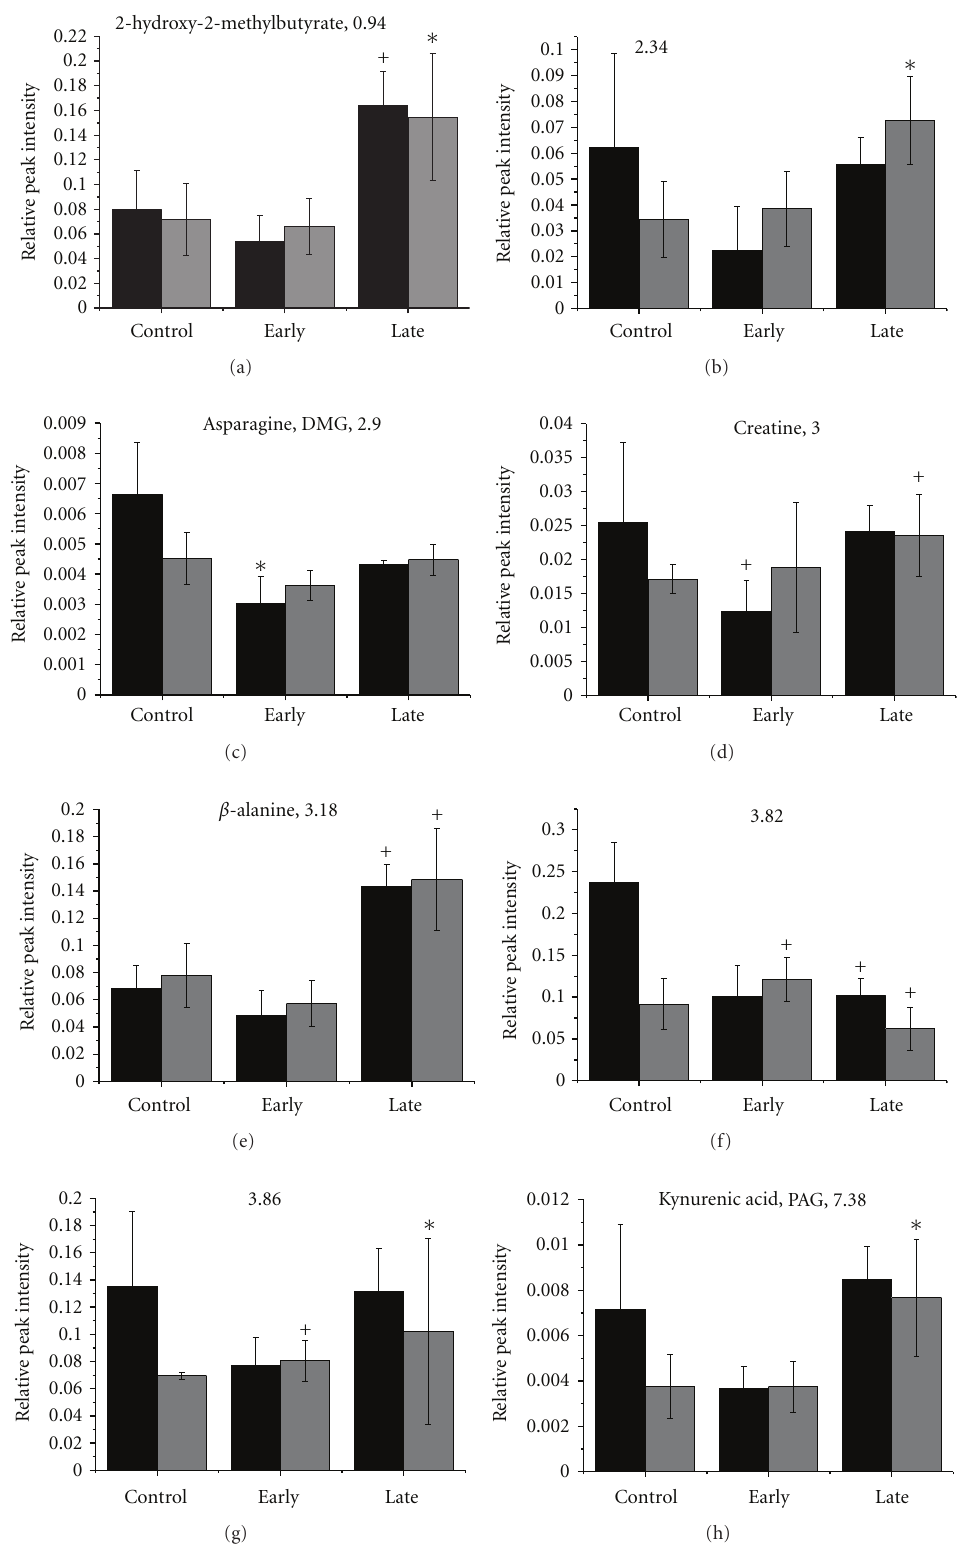
Figure 2: Perturbed metabolite levels in mouse liver at early- and late-stage malarial infection . All peak intensities have been calculated relative to the peak height of 0.132mg/mlDSS present in every sample. Panels showing two metabolites represent overlapping 1 H NMR resonances at the chemical shift mentioned. Where only chemical shifts are mentioned, identity of metabolites could not be confirmed. Black = males and grey = females. ∗ indicates P < . 05, + indicates P < . 08 in comparison to the uninfected controls of the same